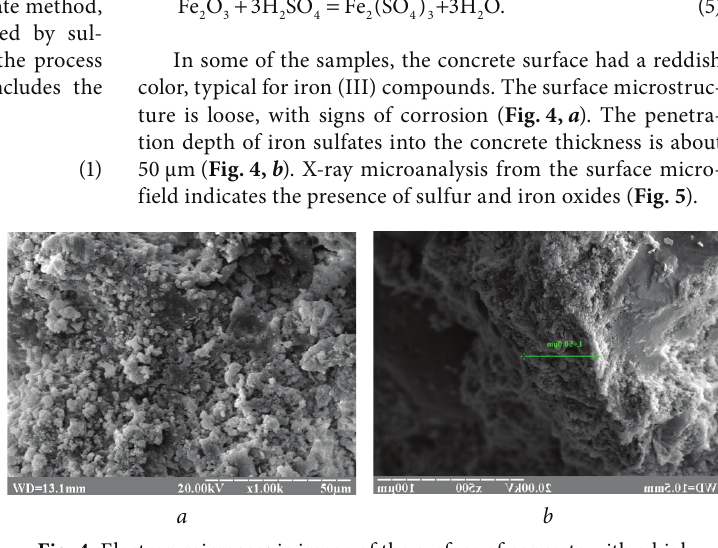
Fig. 4. Electron microscopic image of the surface of concrete with a high content of iron (III) salts: a – frontal view; b − side